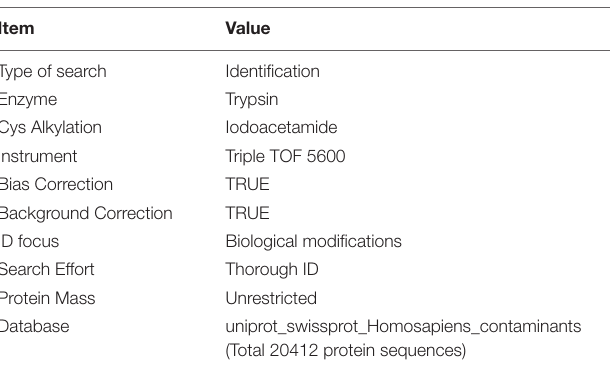
Compared with the normal group *p < 0.05; **p < 0.01.